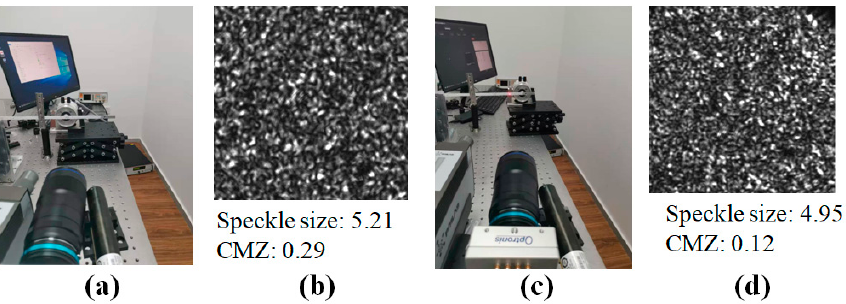
Figure 19. ( a ) Physical diagram of the first experiment. ( b ) One speckle pattern of the first experiment, its speckle size, and its CMZ value. ( c ) Physical diagram of the second experiment. ( d ) One speckle pattern of the second experiment, its speckle size, and its CMZ value.